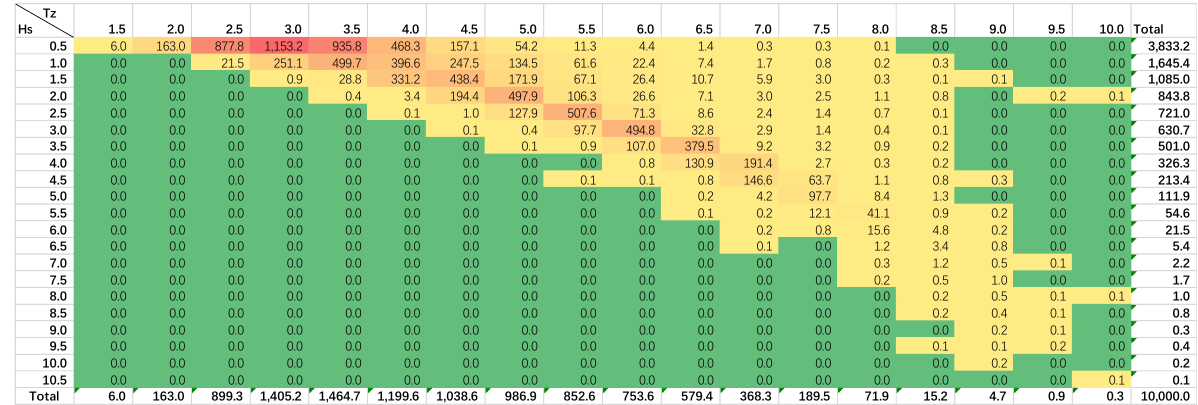
Figure 14. Wave scatter diagram at Site A.